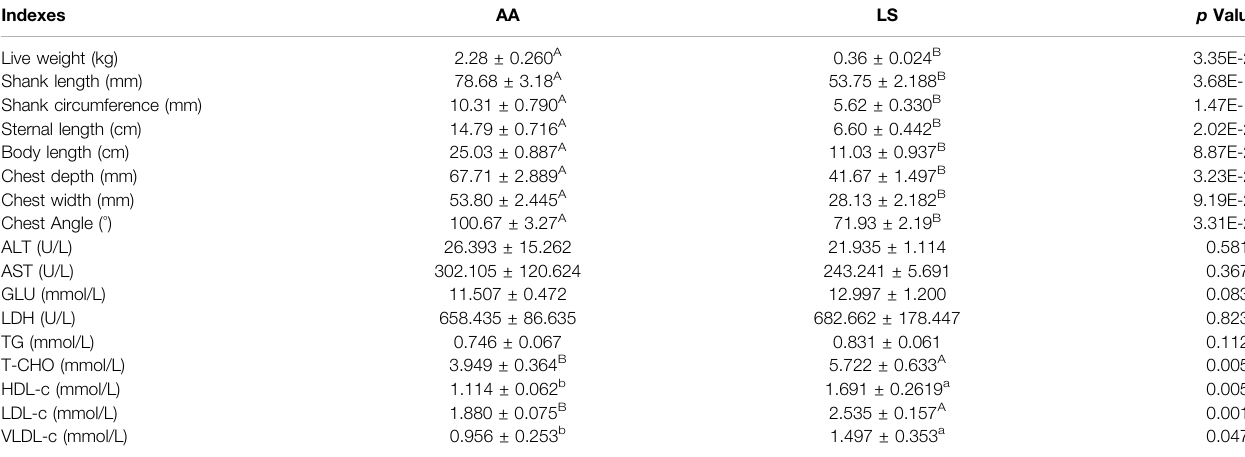
TABLE 1 | The difference of body sizes and serum biochemical indexes between 5-week-old AA broiler and Lushi chicken.